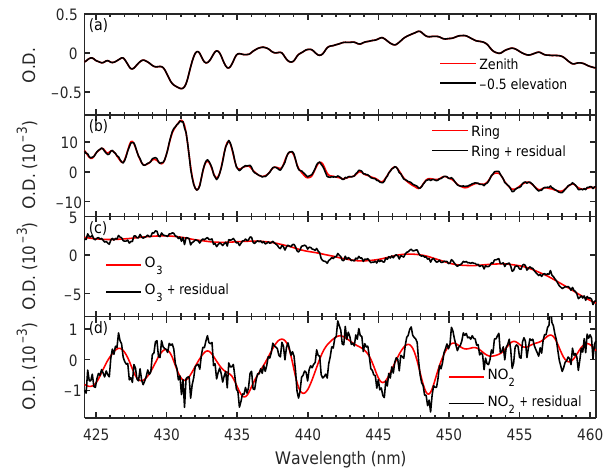
Figure 3. Example of the spectral analysis of NO 2 during SF3- 2013 (14 February 2013) at 20:57UT at an altitude of 17.1km at 28.2 ◦ N, 131.2 ◦ W. The original spectrum was recorded with an el- evation viewing angle of − 0.5 ◦ . Optical densities (O.D.) are in ar- bitrary units. The top panel compares the − 0.5 ◦ spectrum to the solar reference, while the second panel shows the fitted Ring spec- trum. Panel (c) shows the sum of two ozone absorption spectra at different temperatures compared to this sum added to the fit resid- ual. Panel (d) shows the comparison of the absorption of NO 2 for a DSCD of ( 5 . 38 ± 0 . 22 ) × 10 15 moleccm − 2 . Multiple NO 2 absorp- tion bands are clearly identified in this retrieval.